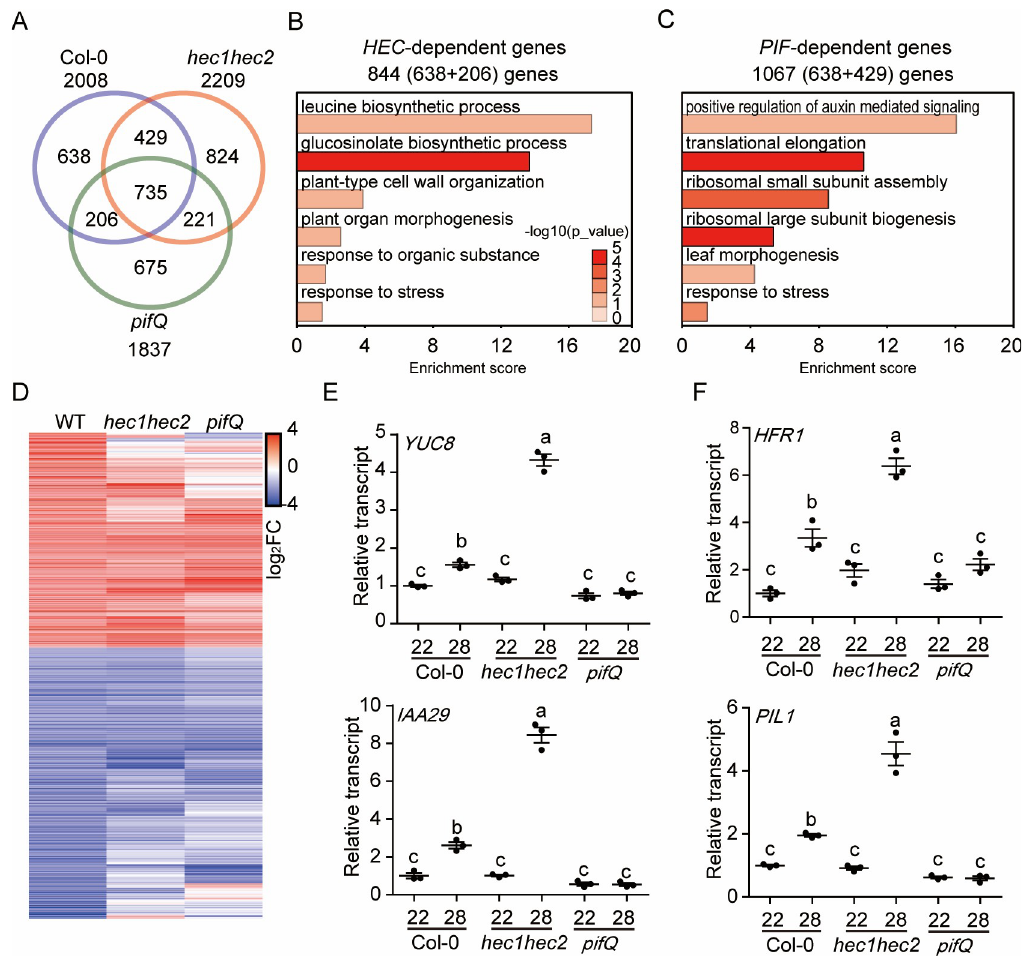
Fig 3. HEC s regulate global gene expression at high ambient temperature. (A) Venn diagrams show differentially expressed genes (DEGs) in wild-type (WT) vs hec1hec2 vs pifQ mutant at high ambient temperature. Six-day-old white light-grown seedlings were transferred to 22˚C or 28˚C for additional 24 hours and total RNA was extracted from three biological replicates for RNA-seq analyses. (B-C) Gene Ontology (GO) analysis of HEC- dependent 844 genes (B) and PIF -dependent 1067 genes (C). (D) Hierarchical clustering from 2008 DEGs from WT show distinct pattern in hec1hec2 and pifQ mutant at high ambient temperature. (E-F) RT-qPCR analysis using growth genes (E), and PIF inhibitor genes (F). RT-qPCR samples were from whole seedlings grown for 6 days at 22˚C and then either kept at 22˚C or transferred to 28˚C for 24 hours. Three biological repeats were performed. Relative gene expression levels were normalized using the expression levels of ACT7 for RT-qPCR. The letters a-c indicate statistically significant differences based on one-way ANOVA analysis with Tukey’s HSD test.